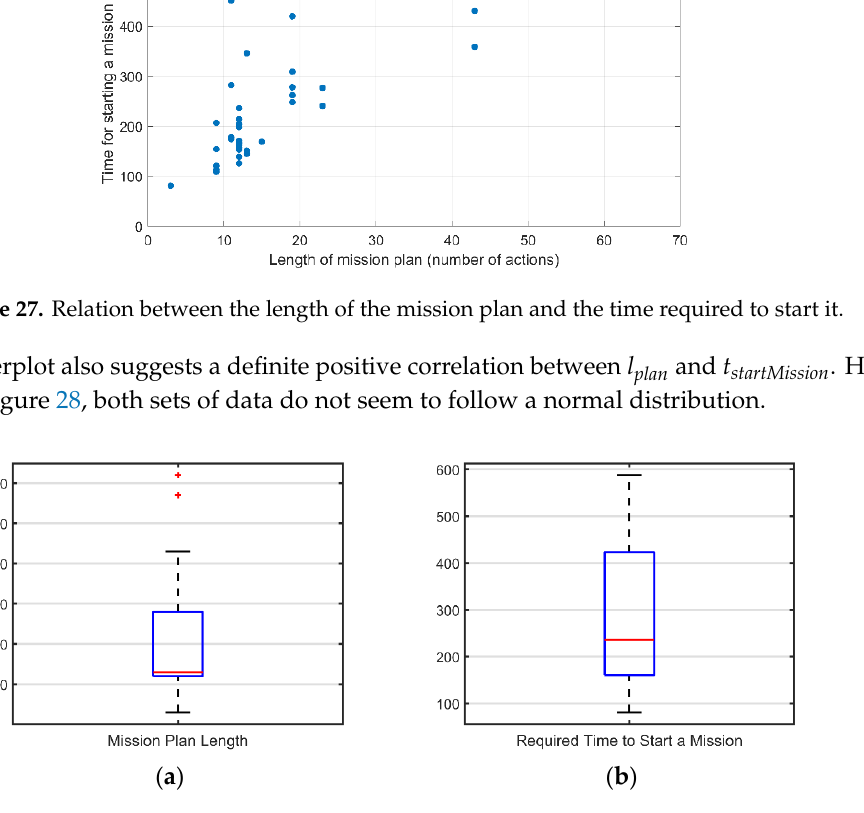
Figure 28. ( a ) Boxplot for the Mission Plan Length ( l plan ). The median is completely displaced to the lower quartile, and there are also a couple of outliers; ( b ) boxplot for the time required to start a mission ( t startMission ).